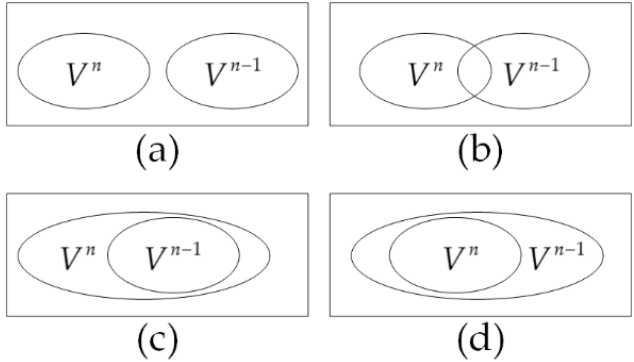
1 n V −  is greater than